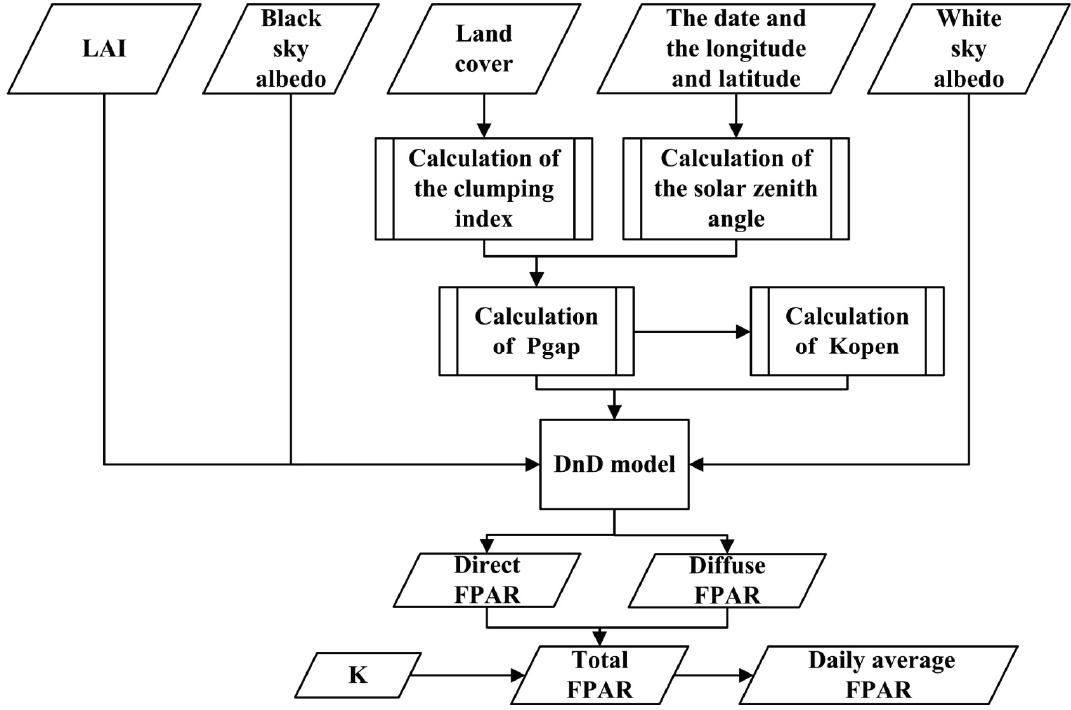
Figure 1. Flowchart of FPAR